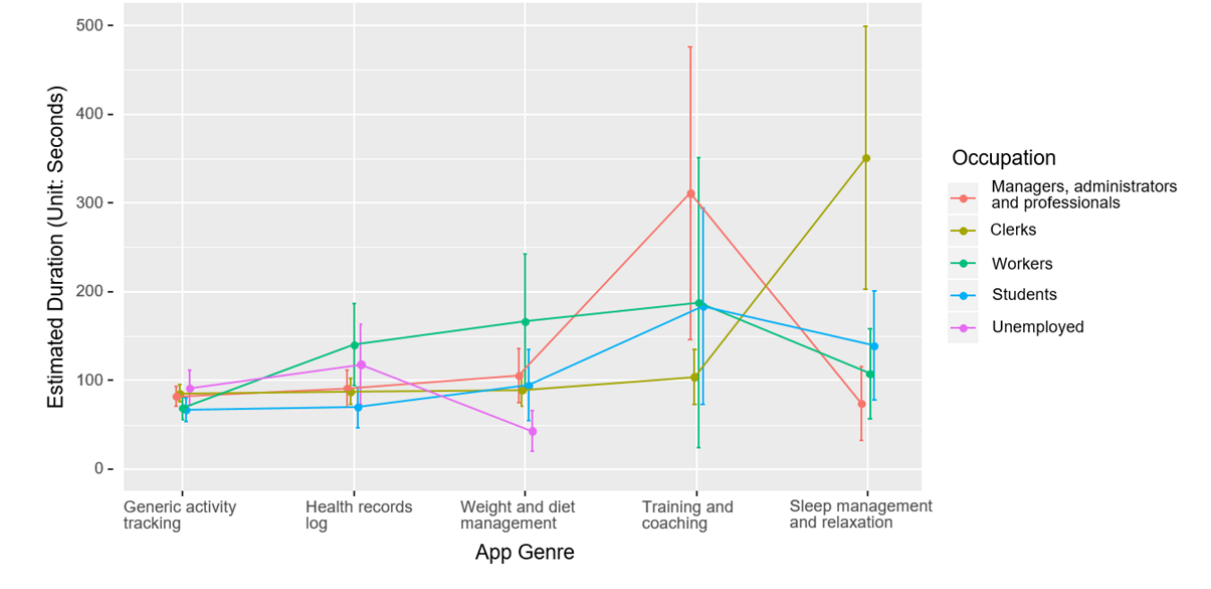
Figure 2. Interaction effect of occupation and app genre on the length of use of mobile health